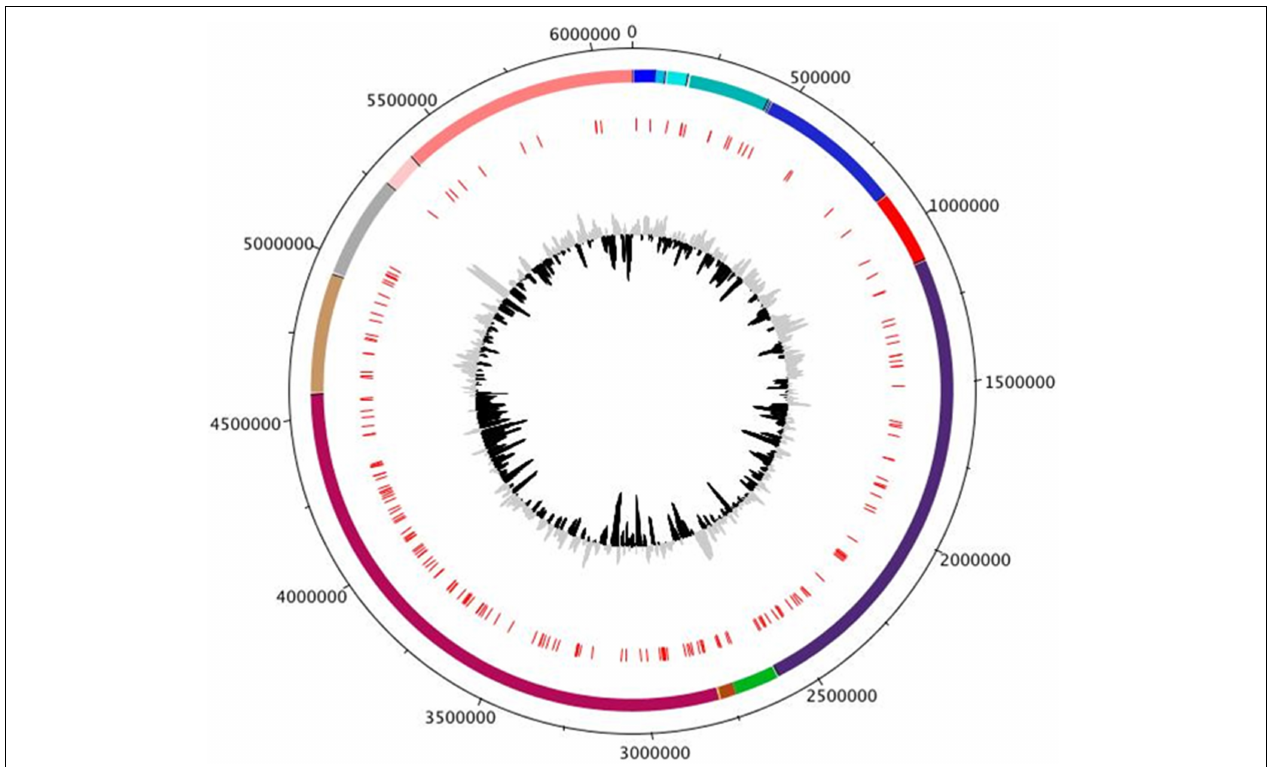
FIGURE 4 | Circular representation of CR1 scaffold assembly showing locations of ambiguous bases. From inside to outside; 1st ring – G + C mol% content, 2nd ring – locations of ambiguous bases (red), 3rd ring – final